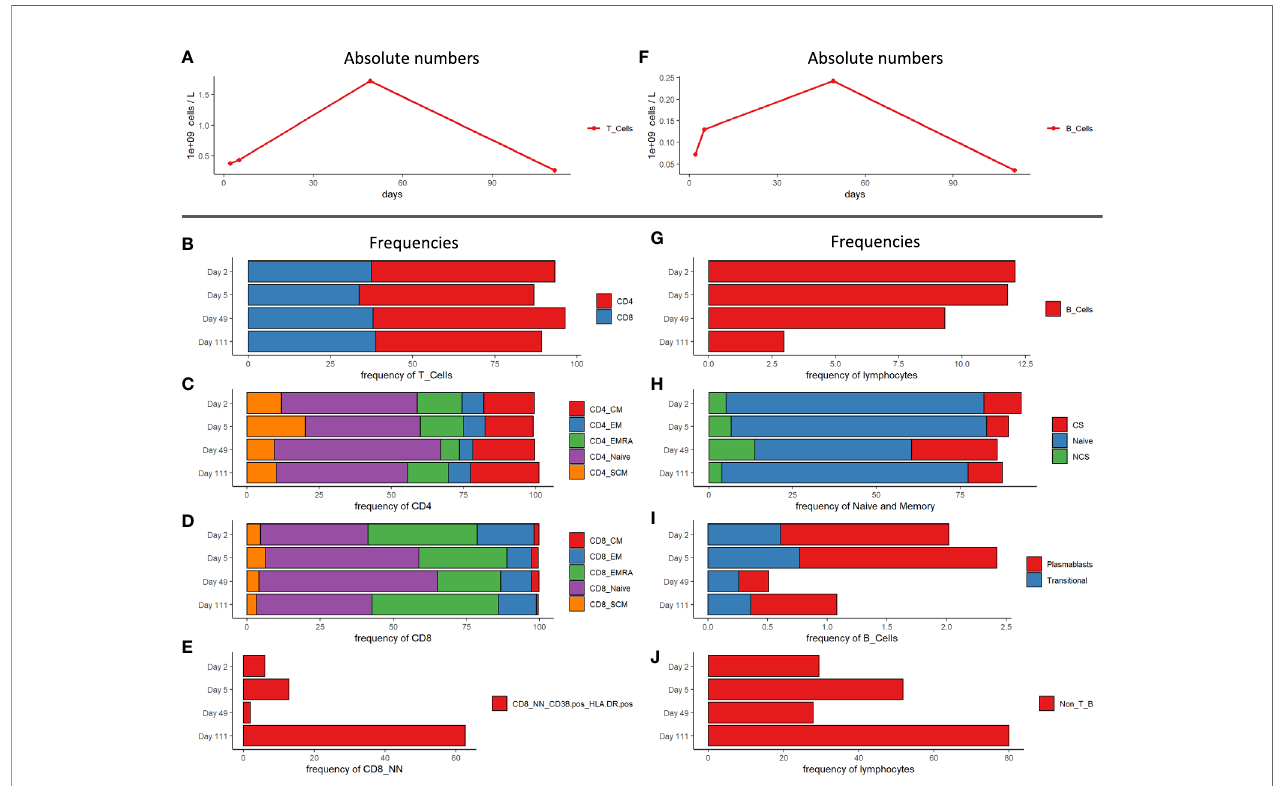
FIGURE 4 | Immunophenotyping of PBMCs of patient at study time points. (A) Absolute numbers of T cells. (B) CD4 and CD8 T cell frequencies. (C) Subpopulations frequencies of CD4 T cells. (D) Subpopulation frequencies of CD8 T cells. (E) CD38 + HLA-DR + frequencies of CD8 non-naïve T cells. (F) Absolute numbers of B cells. (G) B cell frequencies of lymphocytes. (H) Class switched -, non-class switched – and naïve B cell frequencies of naïve and memory B cells. (I) Plasmablast - and transitional B cell frequencies of total B cells. (J) Non-T- and Non-B-cell frequencies of lymphocytes. CM, central memory; EM, effector memory; SCM, stem cell memory; CS, class-switched; NCS, non class-switched; Non_T_B, non-T, and non-B